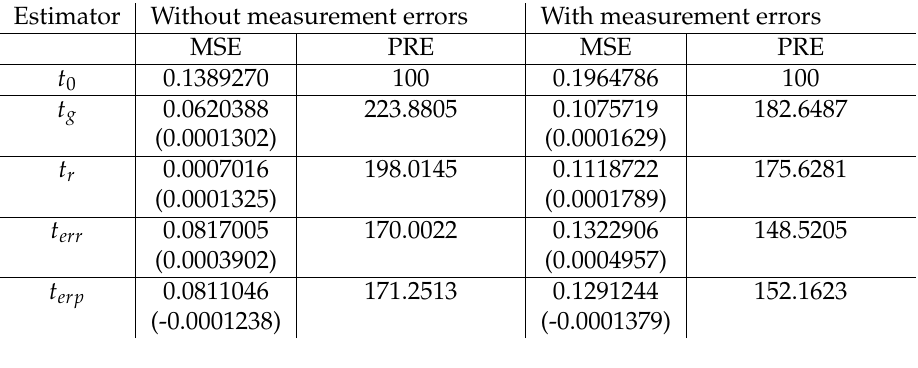
Table 2. Bias (in brackets), MSE and PRE of estimators for population I